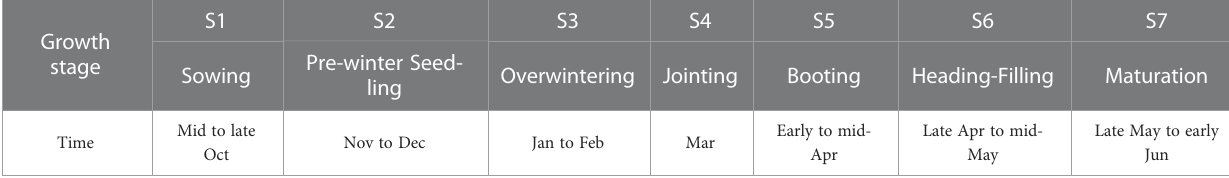
TABLE 2 Growth stages of winter wheat and associated calendar in Huaibei Plain, Anhui Province, China.